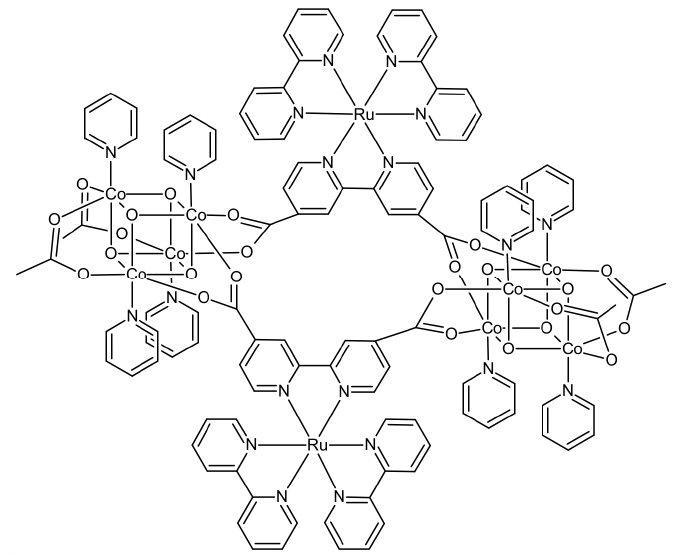
Scheme 4. Schematic representation of assembly 21 .